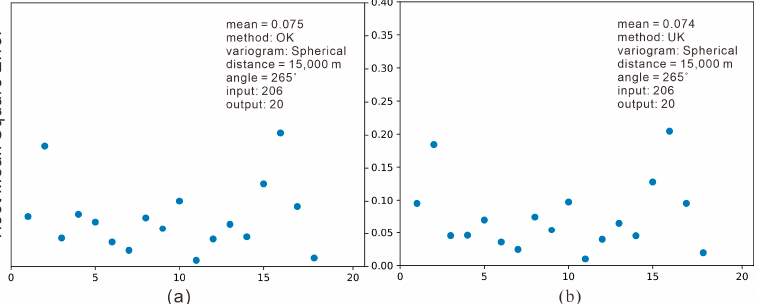
Figure A12. An additional test to compare the RMSE of different methods: ( a ) OK; and ( b ) UK. The mean RMSEs and parameters are listed in the top right-hand corner.